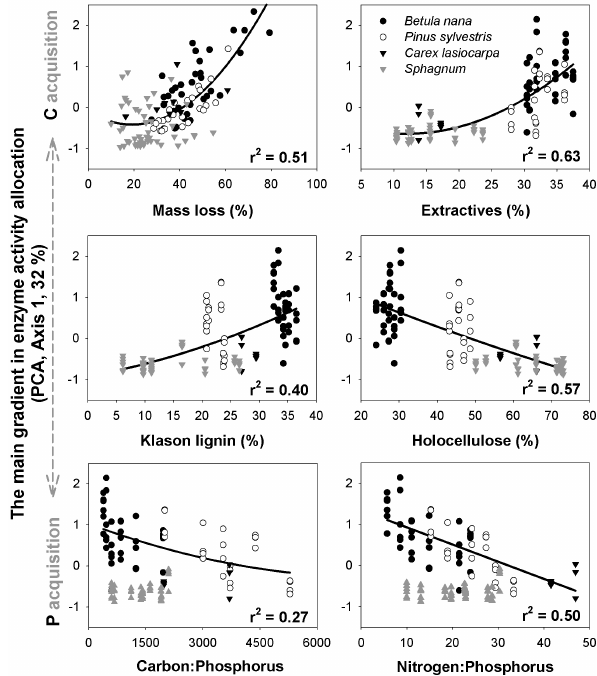
Fig. 2. Correlations between the main gradient in enzyme activity allocation and litter mass loss, initial concentration of extractives (substances easily extractable by hot water), Klason lignin, holo- cellulose, C:P and N:P ratio. The main gradient in enzyme activity allocation (vertical axis of the graphs) represents the first axis from principal component analysis (PCA) on standardized activities of each enzyme within a sample. This main gradient accounted for 32% of the total variation in enzyme activities, and was positively associated with the acquisition of C (i.e., positively correlated with the standardized activities of C-acquiring enzymes) and negatively associated with the acquisition of P (i.e., negatively correlated with the standardized activities of P-acquiring